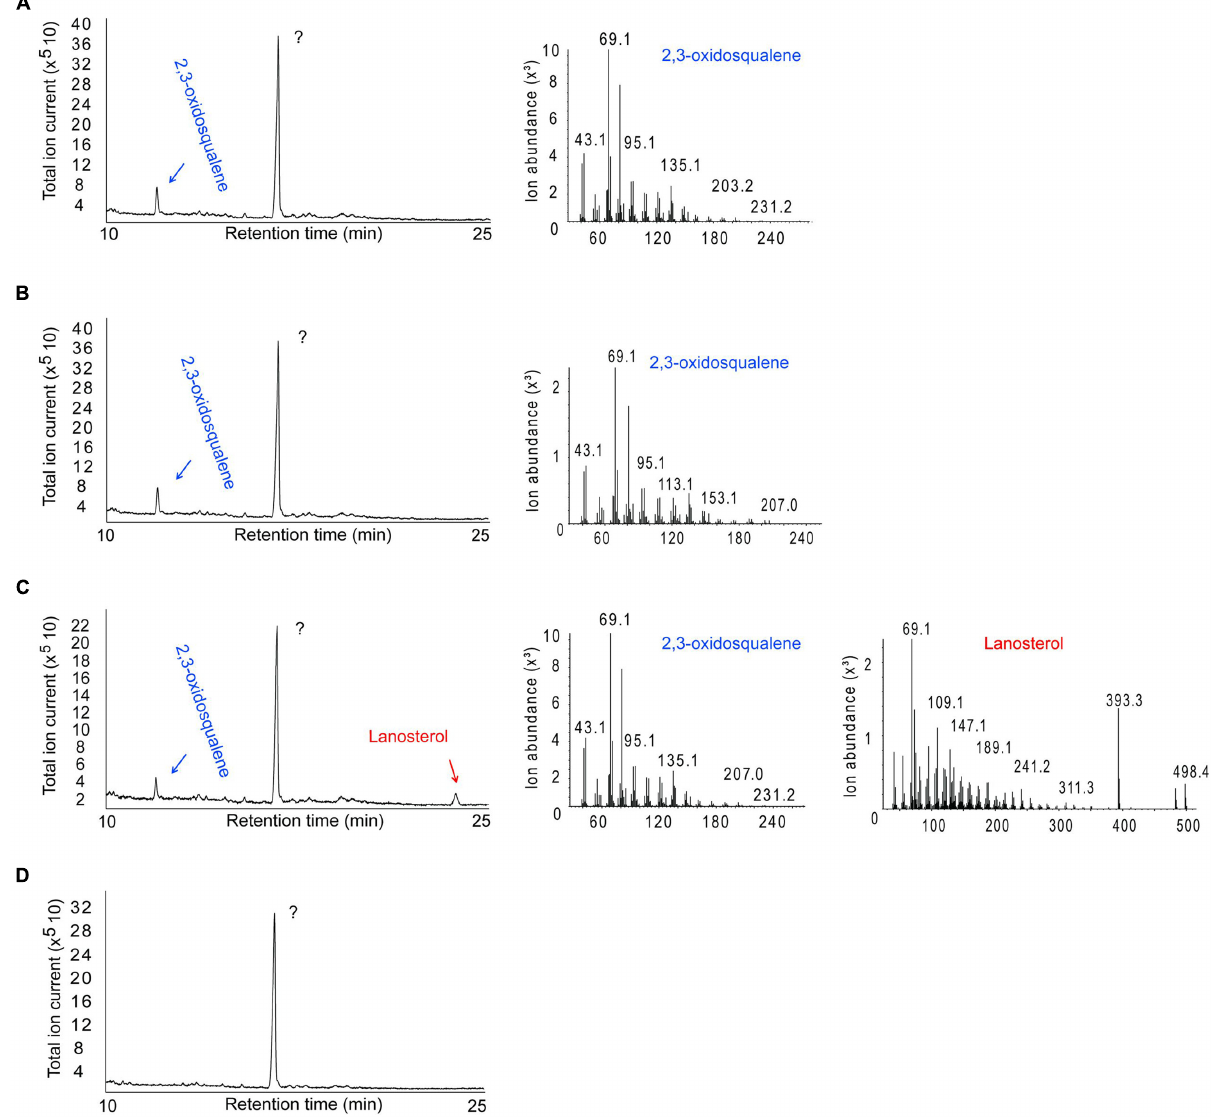
FIGURE 5 | GC-MS analysis of the product formed by E. coli cells expressing Sp LASA and grown in the presence of the OS substrate. (A) Control E. coli BL21 cells producing green fluorescent protein showed no conversion of the OS substrate. (B) E. coli cells that expressed Sp LASA but that were not induced by IPTG for protein expression showed no conversion of OS. (C) E. coli cells that expressed Sp LASA and were induced by IPTG for protein expression specifically converted a portion of the OS substrate to LA. (D) Negative control performed on E. coli cells producing Sp LASA and grown in the absence of the OS substrate shows no conversion of OS. The major peak detected in all samples is an unidentified compound that does not correspond to any sterol as judged by MS analysis (not shown). The identity of the OS and LA GC peaks were assigned by comparison to standards and confirmed by inspection of their MS fragmentation